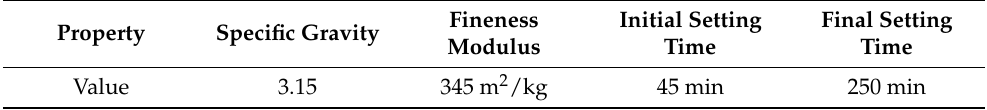
Table 1. Properties of Portland